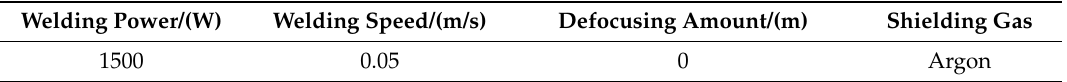
Table 1. The main parameters of laser welding.